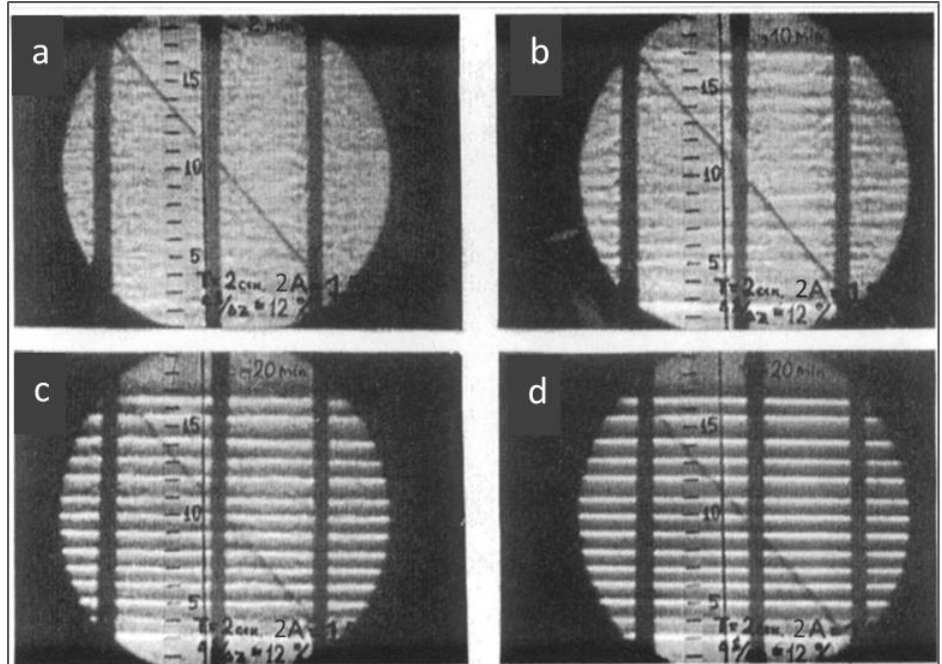
Figure 1. Consecutive shadowgraphs illustrate the formation of the step-like fine structure during long-term stirring of linearly stratified water column by horizontally oscillating vertical rods. The shadowgraphs were obtained during the experiment as follows: ( a ) top left at 10 min, ( b ) top right at 30 min, ( c ) bottom left at 240 min, ( d ) bottom right at 630 min. Experiment setup parameters were as follows: 𝐴 = 0.75 cm, 𝑑 = 0.65 cm, 𝑇 = 2 s, 𝑁 2 = (𝑑𝜌/𝑑𝑧)𝑔/𝜌 = 8.4 s − 2 , where A is amplitude, 𝑑 is diameter of the rod, T is period of rod oscillation, N is Brent-Väisälä frequency, 𝑑𝜌/𝑑𝑧 is density gradient, 𝜌 is water density, 𝑔 is gravity acceleration).